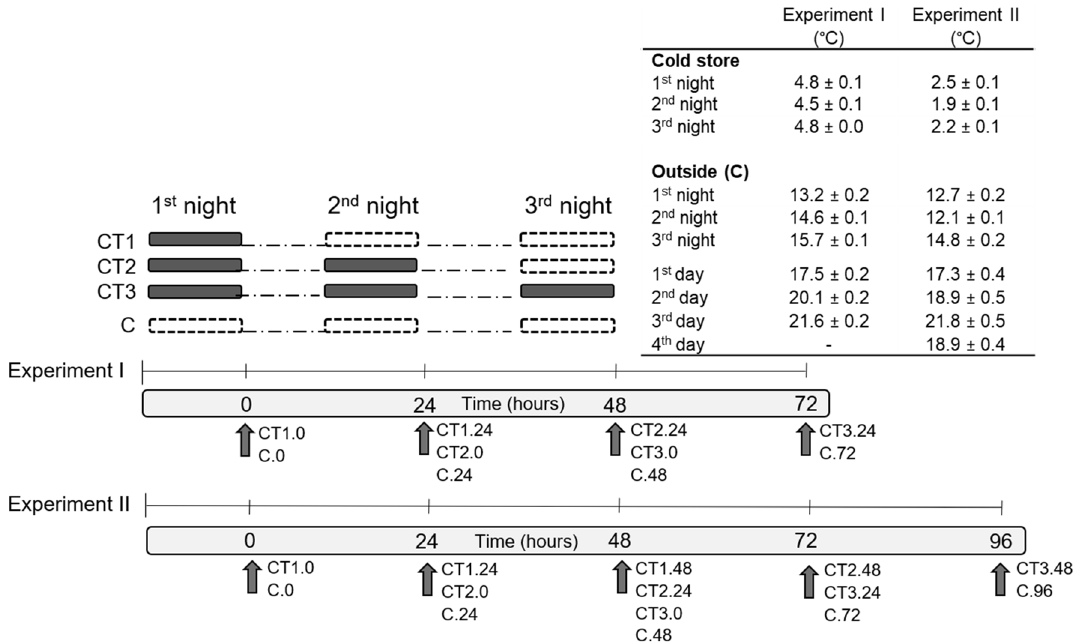
Figure 1. Illustration of the experimental set up (CT1, CT2, CT3, chilling treatments; C, control), the sampling procedure/time (hours) and temperatures (presented as mean ± SE for night-time temperatures in cold store and outside and daytime temperatures; °C) for experiments I and II. A black filled rectangle indicates the night-time exposure to chilling temperature in cold store, while white filled rectangle indicates the night under natural conditions (outside). The arrows indicate the sampling time, with the list of measured CT.time levels next to the